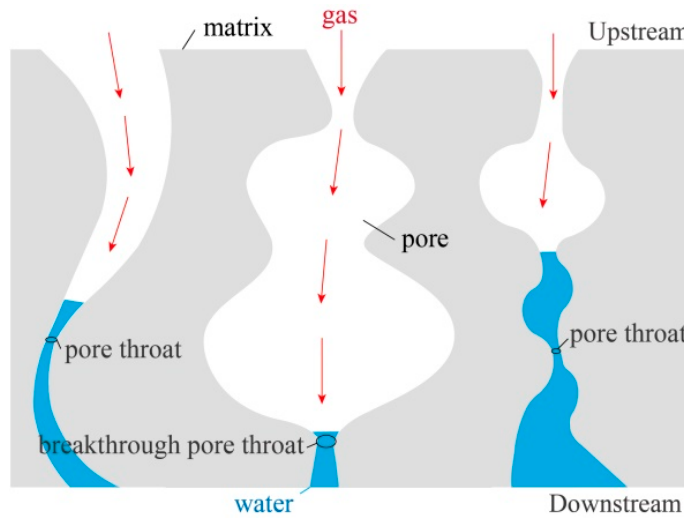
Figure 12. Illustration of the gas breakthrough path.